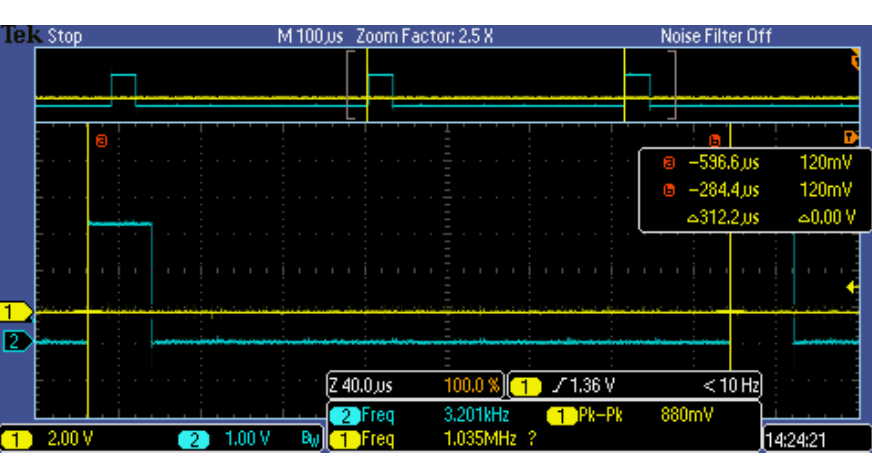
Figure 22. Oscilloscope capture of the 3.2 kHz pulse timing before PPS signal.